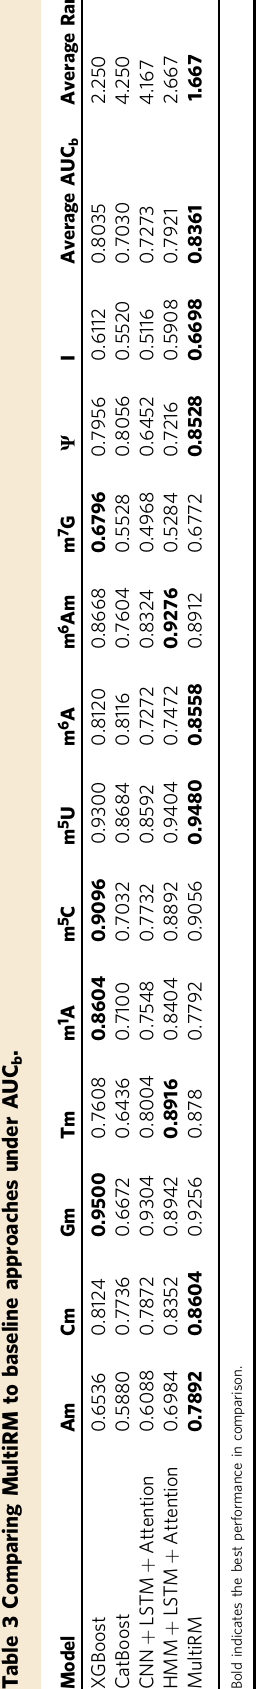
Table 4 Performance summary of